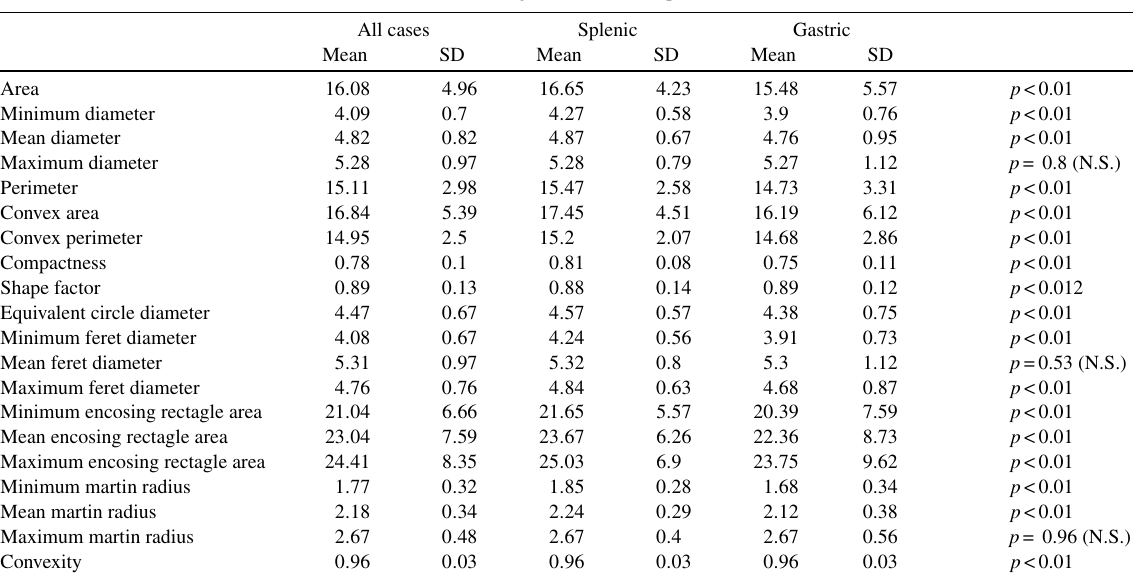
The values of the geometric nuclear